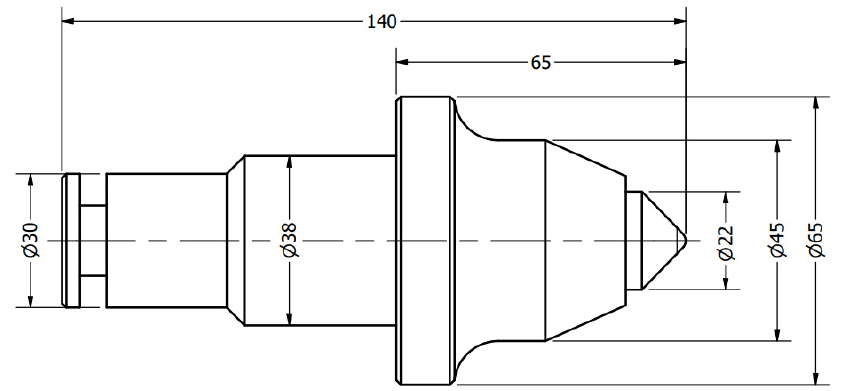
Figure 2. Technical drawing of the inspected conical pick. This geometry corresponds with the master model (CP0).